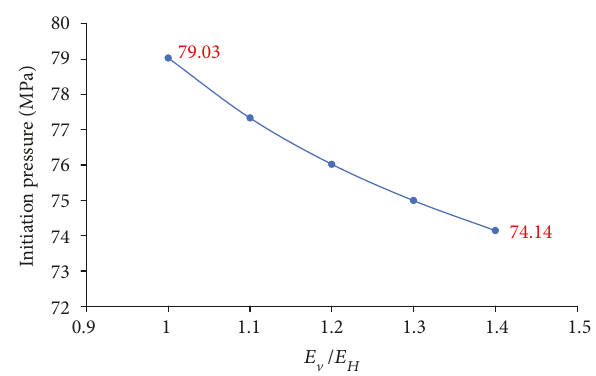
Figure 9: The relationship curve between initiation pressure and E